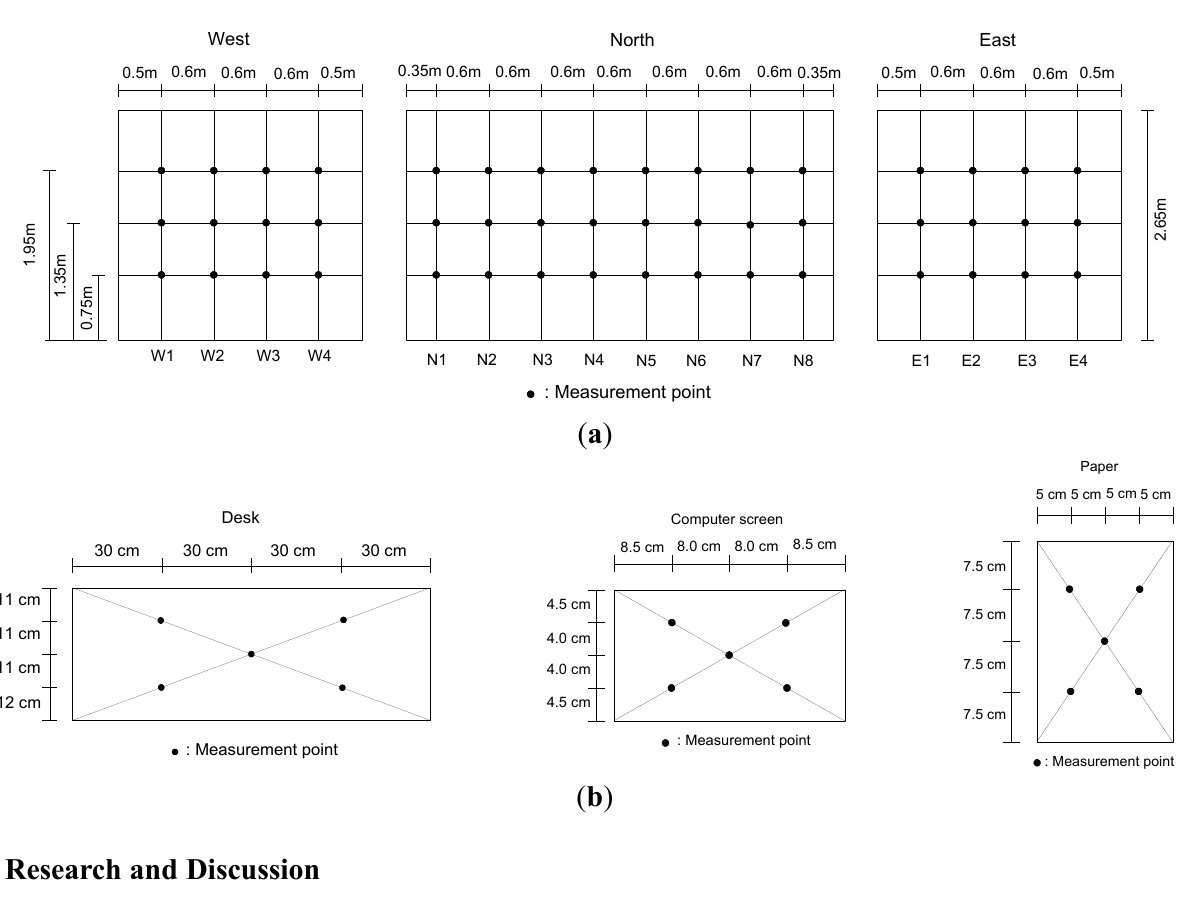
Figure 4. Measurement points for illuminance and luminance levels on indoor surfaces ( a ) Wall surfaces; ( b ) Desktop, computer screen and paper